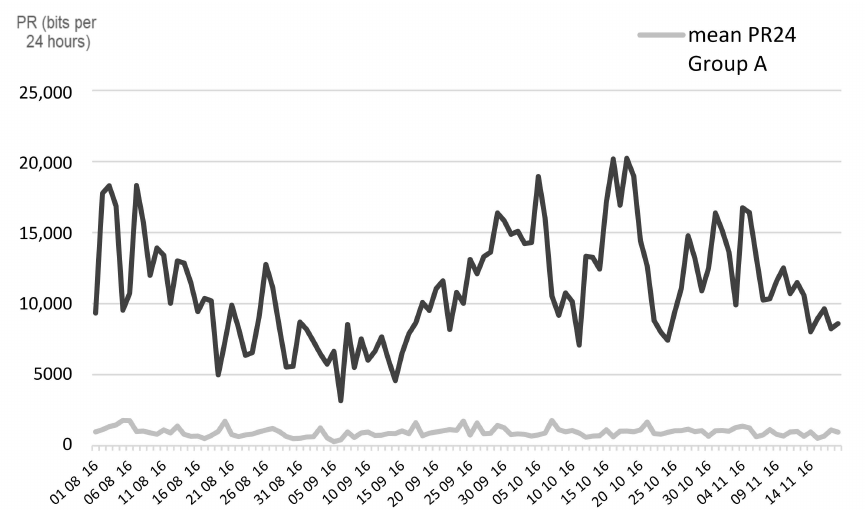
Figure 3. Mean pedometer records per 24 h (PR24) in 2 groups of feeder cattle kept in open-air (Group B) or under fly-proof protection (group A) from August to November 2016. Legend : Black line: mean pedometer records (PR24) of cattle in Group B; Grey line: mean pedometer records (PR24) of cattle in Group A.